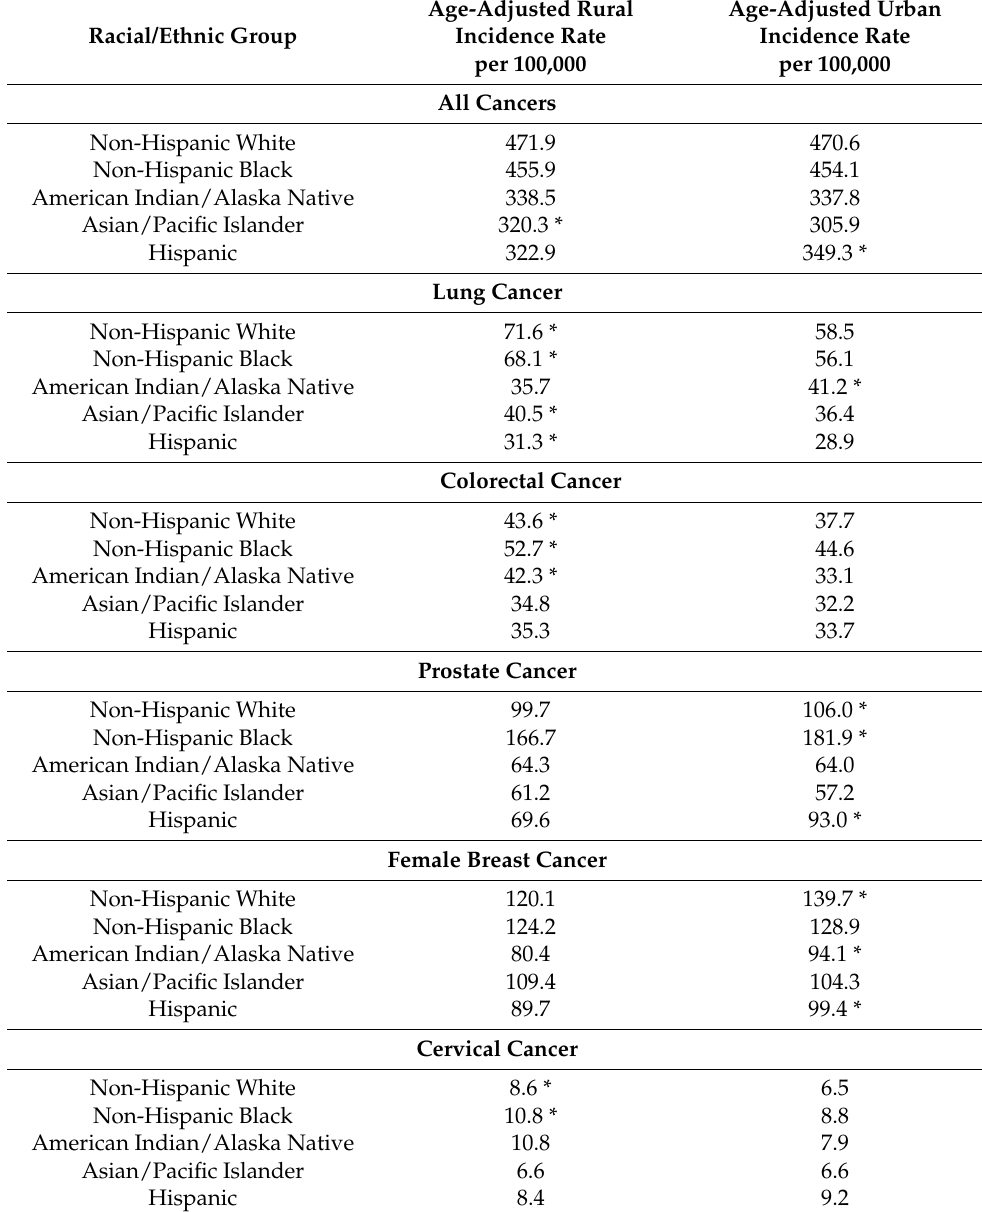
Table 1. Rural and urban age-adjusted cancer incidence rates across racial/ethnic groups, 2013–